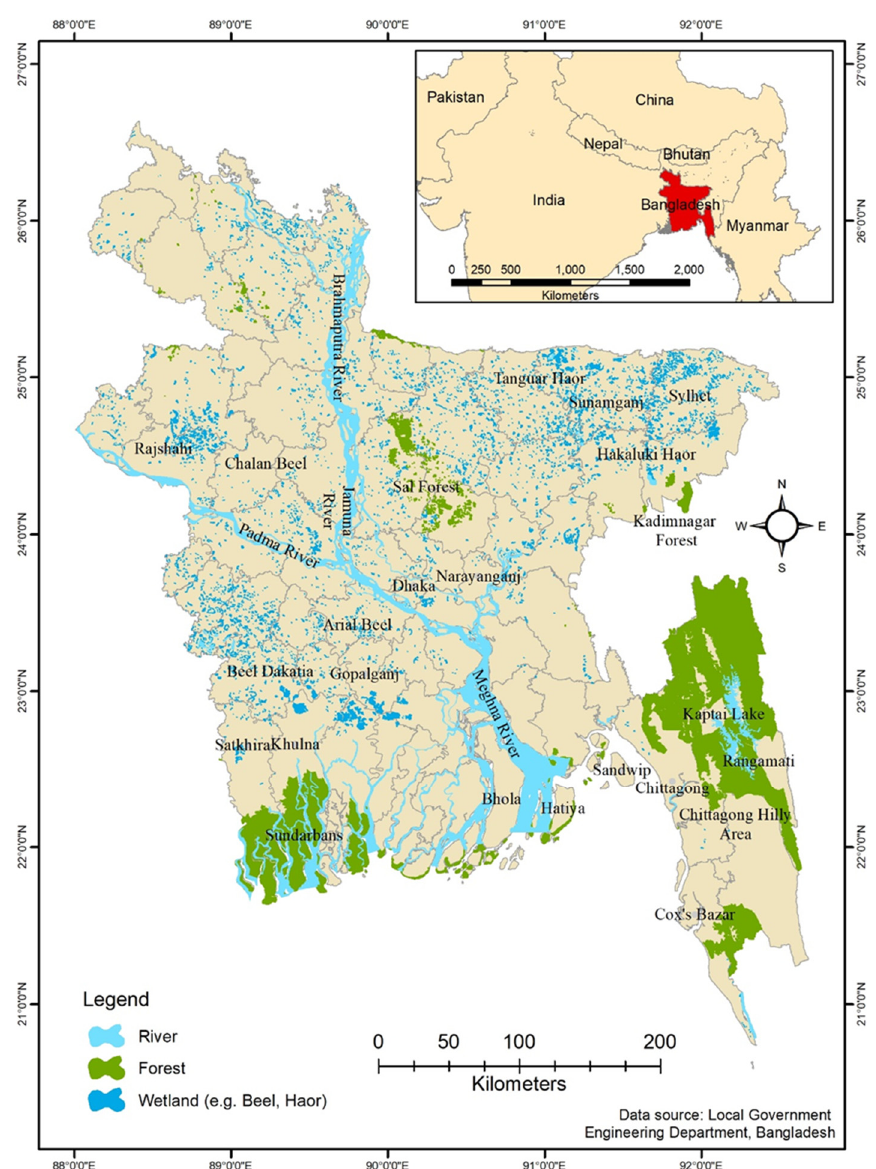
Figure 1. Study area. Key locations where remote-sensing studies have been conducted are included.